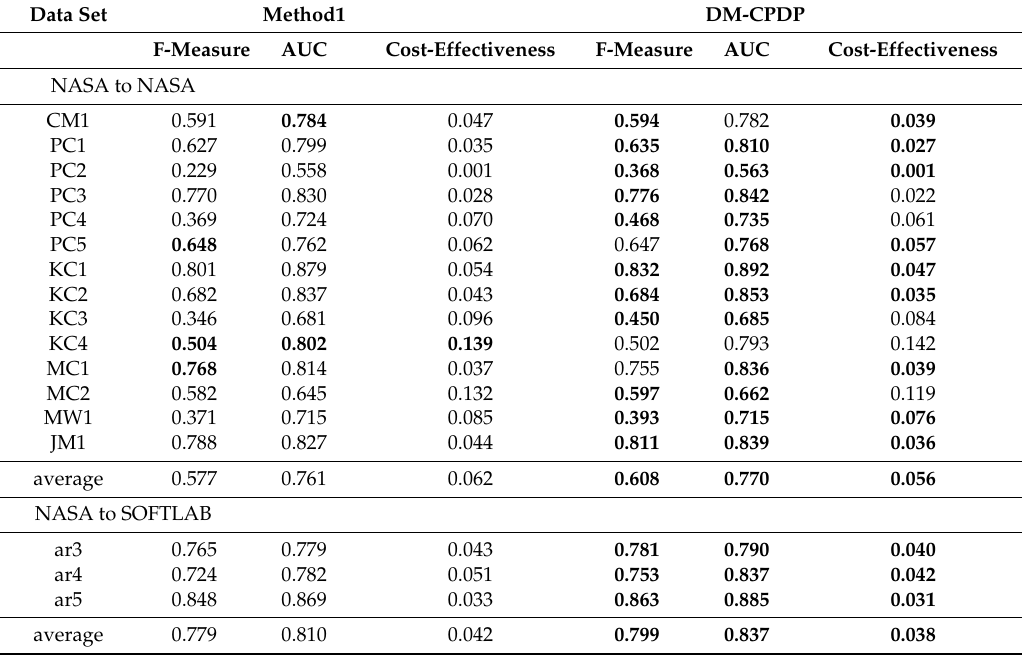
Table 10. Different dataset selection